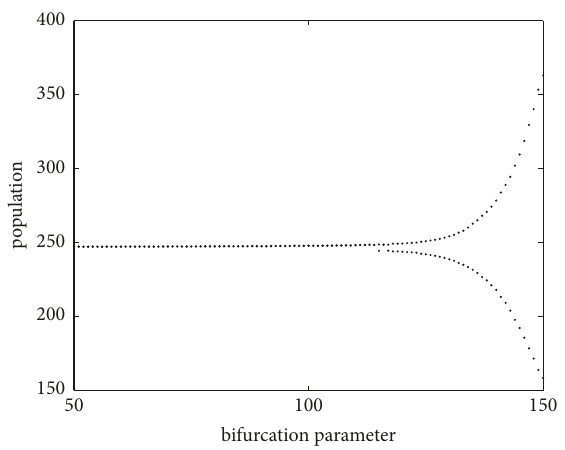
Figure 5: Bifurcation diagram with respect to the parameter 𝐴 ; other parameter values are 𝑟 = 2.65 , 𝐾 = 900 , 𝑎 = 0.02 , 𝑐 = 0.215 , and 𝑚 = 1.06 .